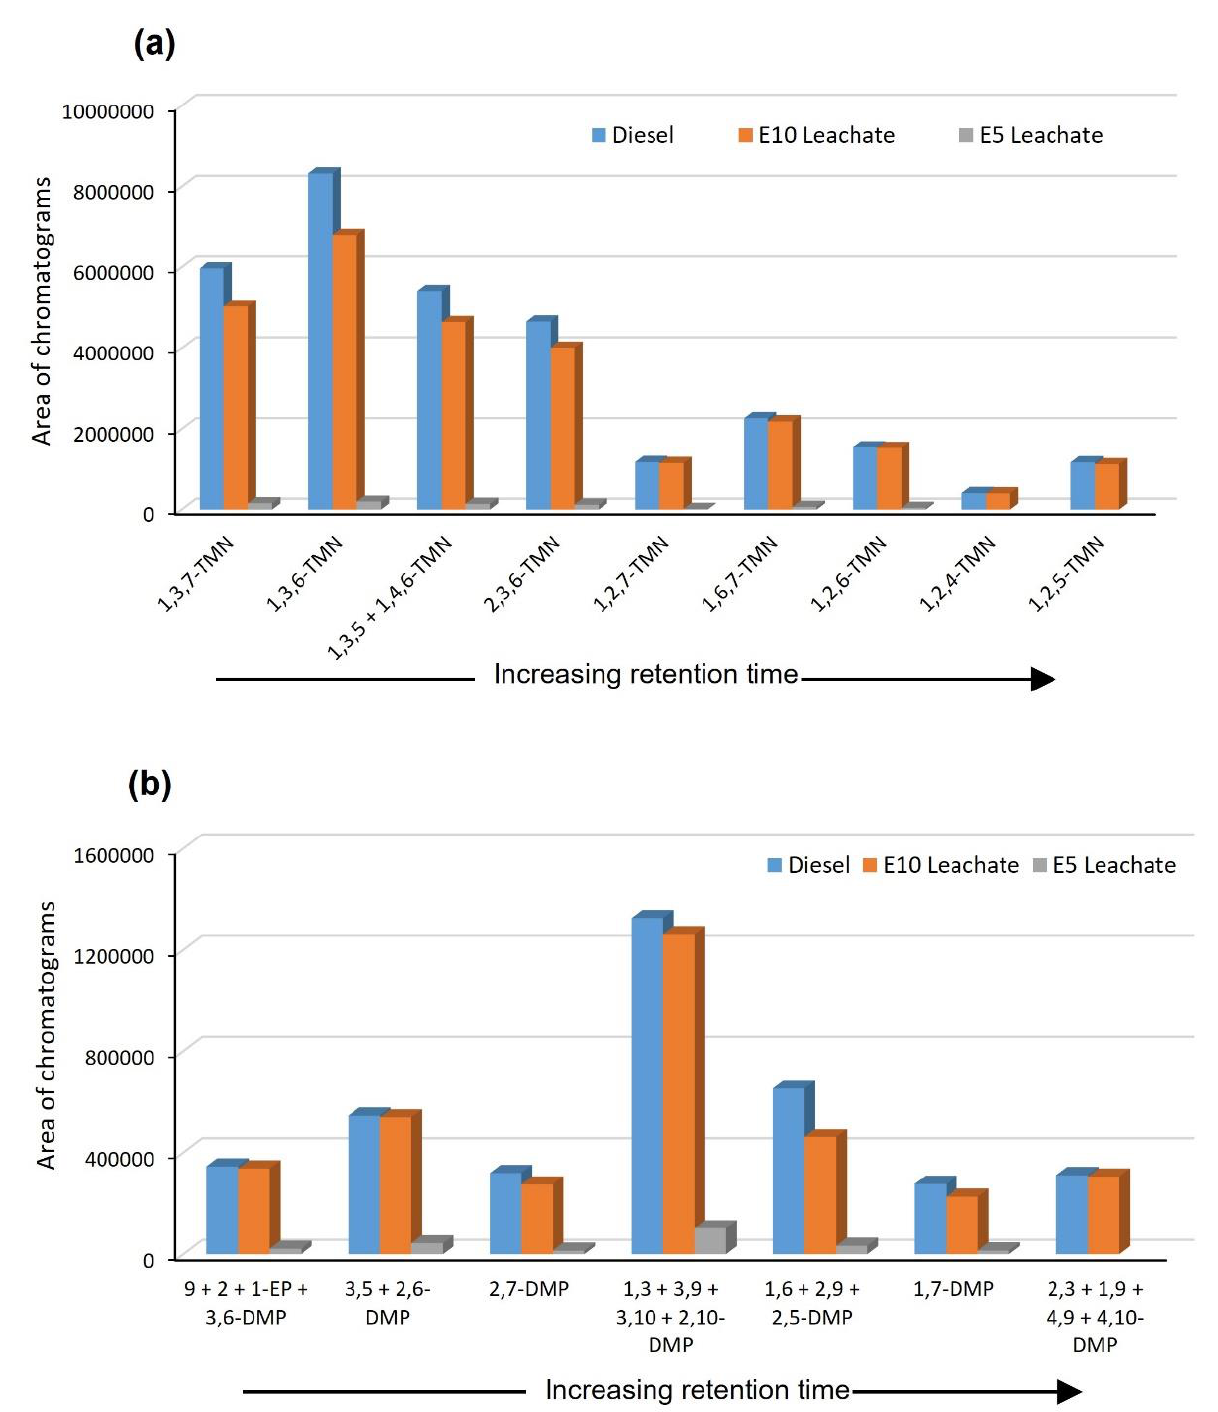
Figure 2. Comparison of the amount of ( a ) trimethylnaphthalenes (TMN) and ( b ) dimethylphenan- threnes (DMP) and ethylphenanthrenes (EP) in diesel fuel, with the amount eluted by 10% and 5% ethanol addition in the E10 and E5 leachates.